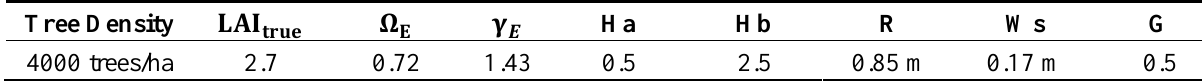
Figure 2. The young jack pine (YJP) site located in the BOREAS southern study area situated near Candle Lake, Saskatchewan, Canada (53.975°N, 104.650°W). The projection is UTM 13 North, WGS84. The background image is a true-color composite image from Landsat8/TM that was acquired on 8 August 2014. Table 1. The canopy structure parameters of the YJP site. Ha is the height of the lower part of the tree with no foliage; Hb is the height of the crown; R is the mean radius of the tree crowns; Ws is the mean width of foliage elements projected on a plane perpendicular to the solar direction; and G is the leaf projection function in Equation